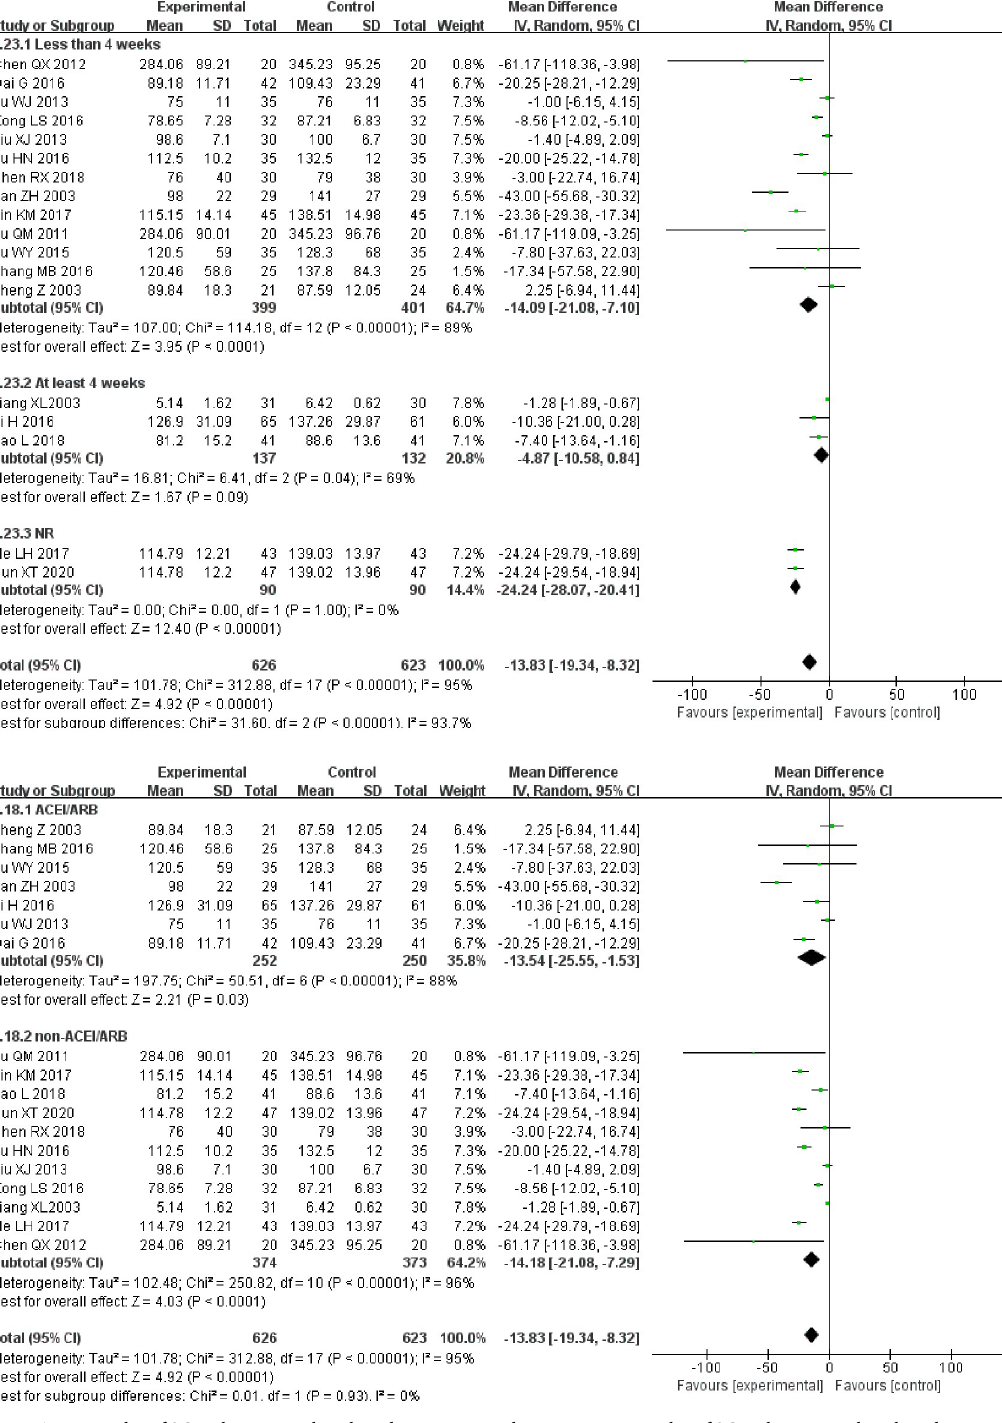
PLOS ONE | https://doi.org/10.1371/journal.pone.0269111 May 26,